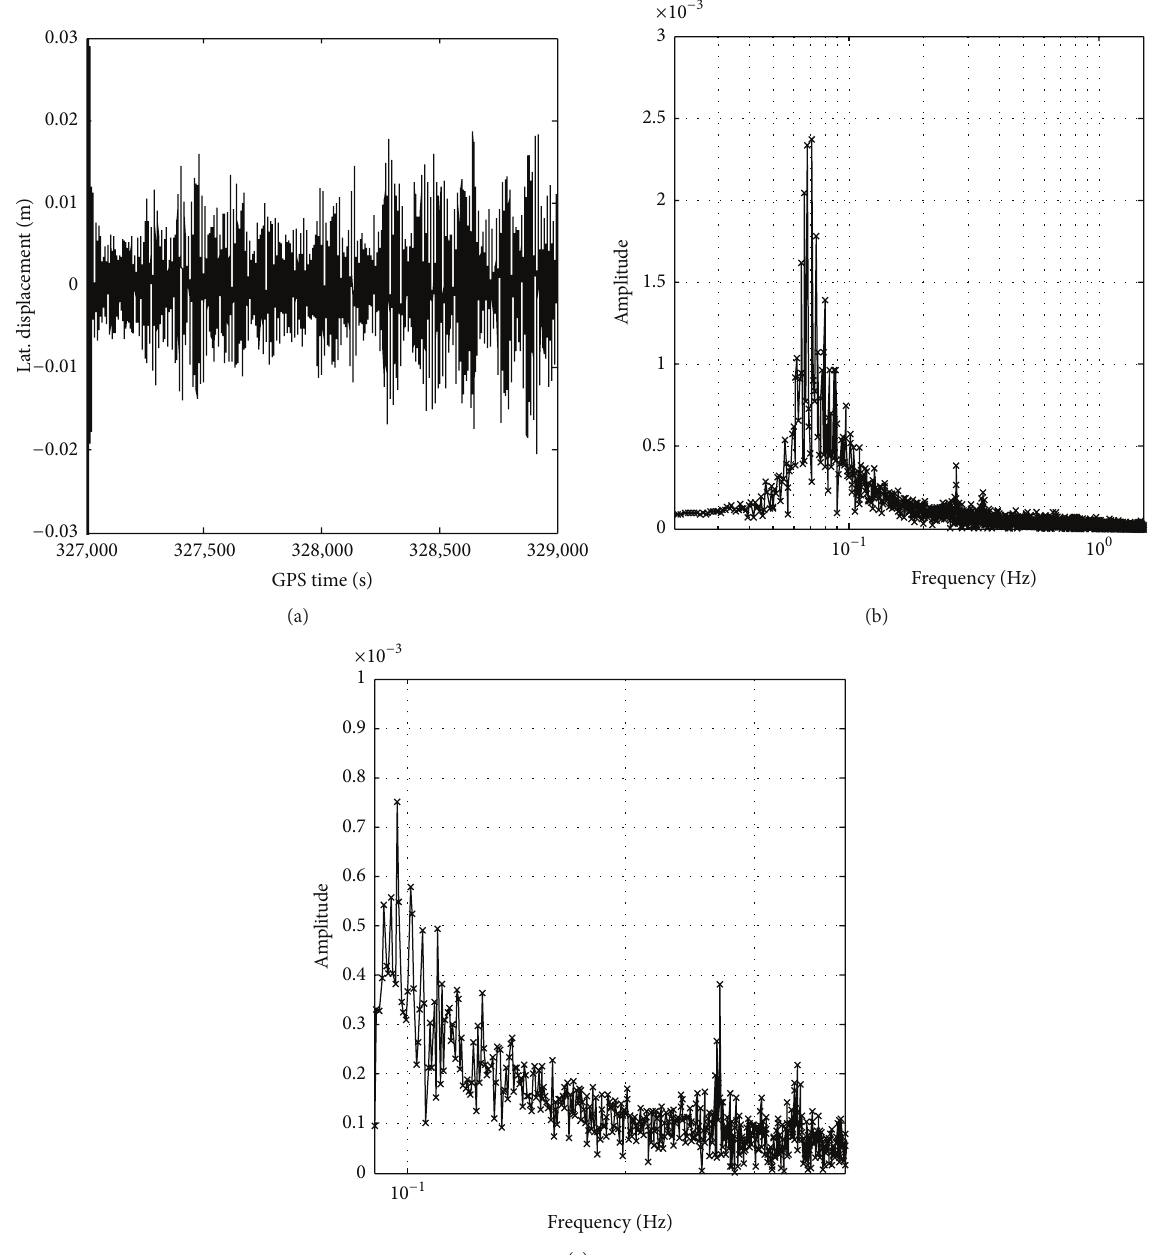
Figure 16: The filtered lateral displacements (a), corresponding vibration frequency ((b), full-scale band), and zoom-in of high frequency component (c) during the wind speed increasing